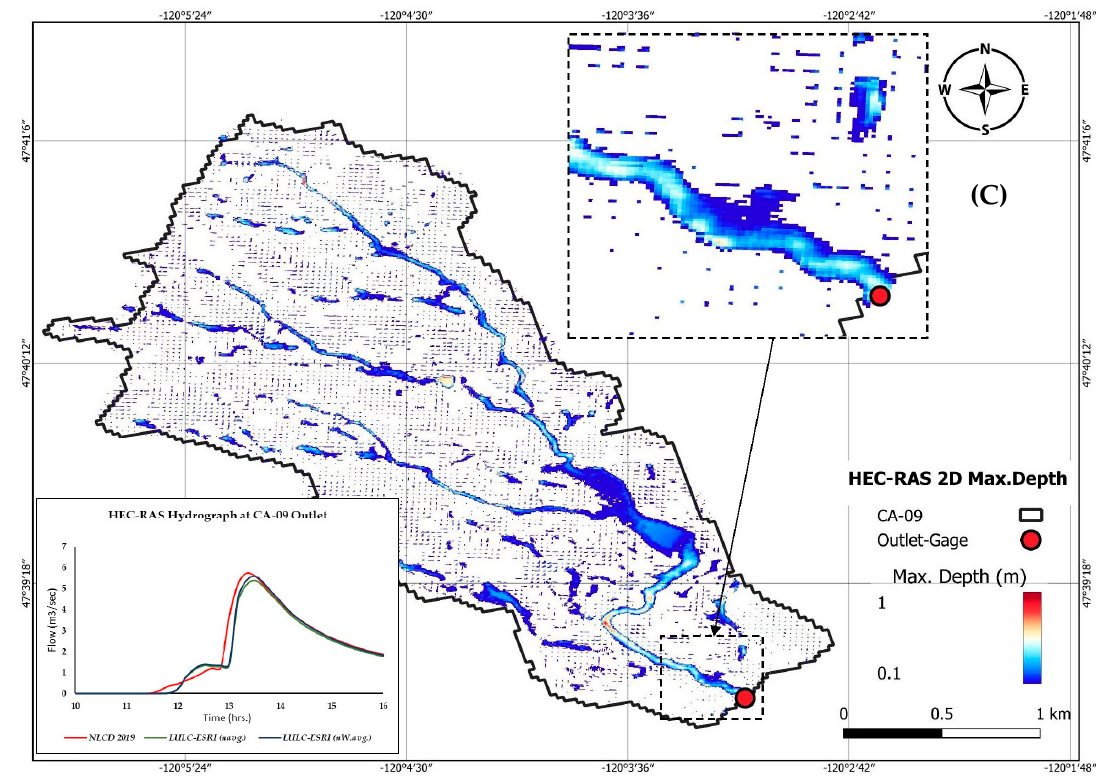
Figure A12. HEC-RAS 2D calibration results, maximum depth, hydrograph at outlet ( A ) Catchment CA-07, ( B ) Catchment CA-08, ( C ) Catchment CA-09.